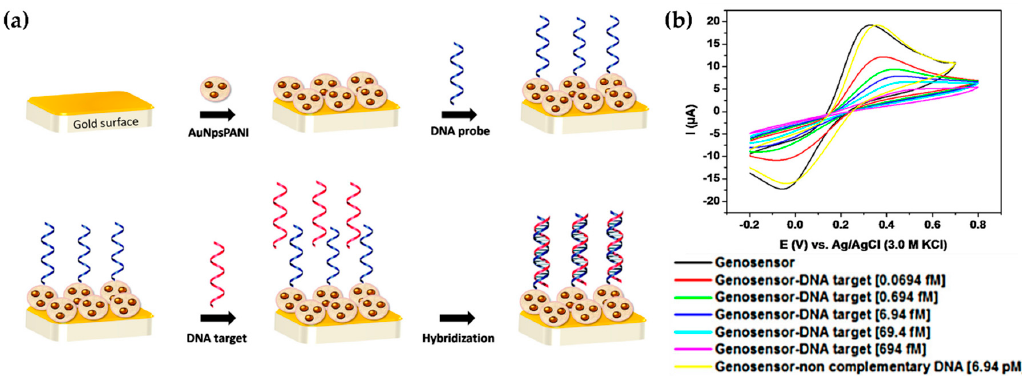
Figure 7. ( a ) Schematic representation of the PAni-AuNPs/DNA construction and ( b ) cyclic voltammograms or the biosensor exposed to different concentrations of recombinant plasmid containing the BCR/ABL fusion gene breakpoint cluster region- Abelson tyrosine kinase gene (DNA target: 0.0694, 0.694, 6.94, 69.4, 694 fM) and nonspecific plasmid (negative control). Adapted with permission from reference [38]. Copyright © 2016 Elsevier B.V.